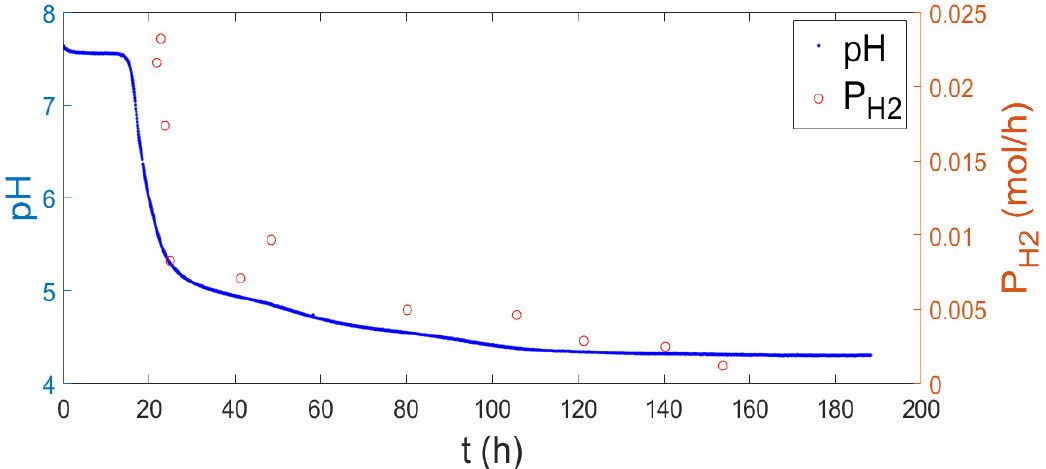
Figure 1. The pH ( left ) and hydrogen production ( right ) evolution over time.